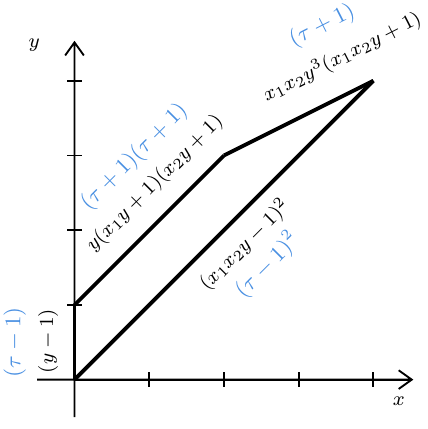
Figure 1 . Newton polygon N ( A ) and face polynomials for diag(2 ; 2)